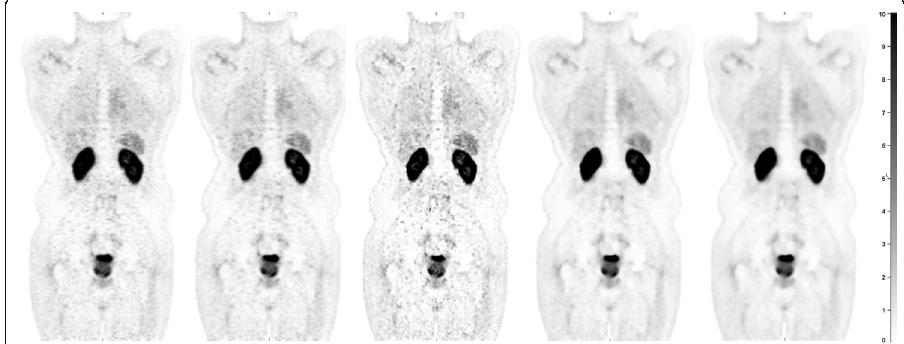
Fig. 9 Coronal views of prostate cancer patient, scanned with 68 Ga-PSMA with the data reconstructed using OSEM+TOF 6.4 , PSF 6.4 , BPL 200 , BPL 800 and BPL 1200 from left to